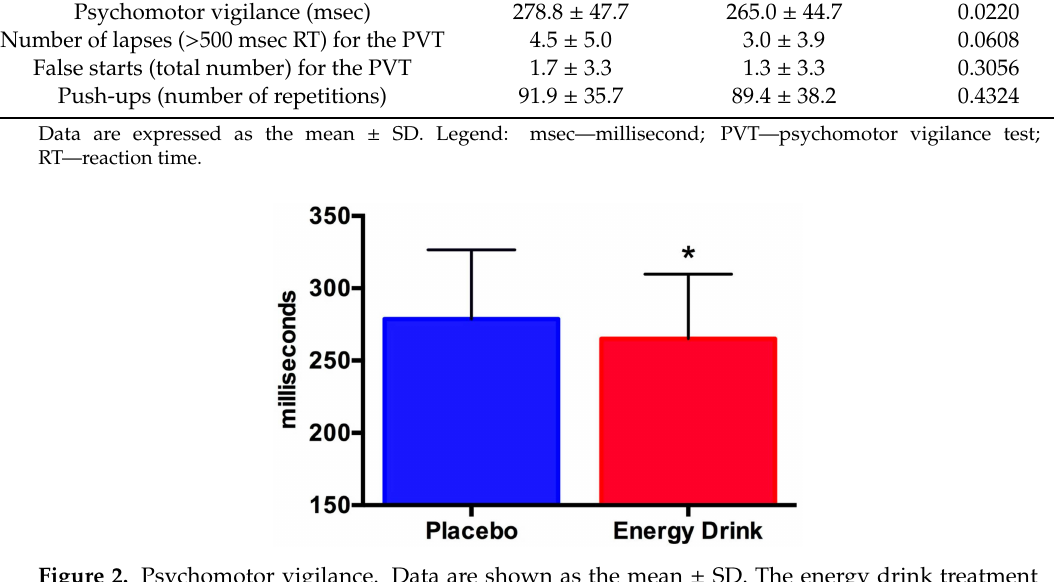
Figure 2. Psychomotor vigilance. Data are shown as the mean ± SD. The energy drink treatment improved PVT reaction time (* p = 0.0220).